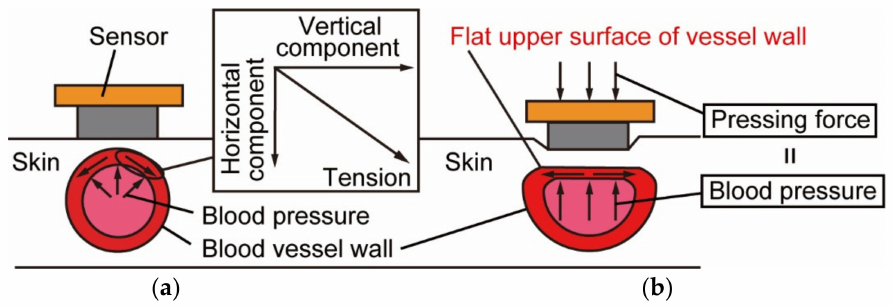
Figure 3. The principle of the arterial tonometry method: ( a ) Without pushing force; ( b ) With moderate pushing